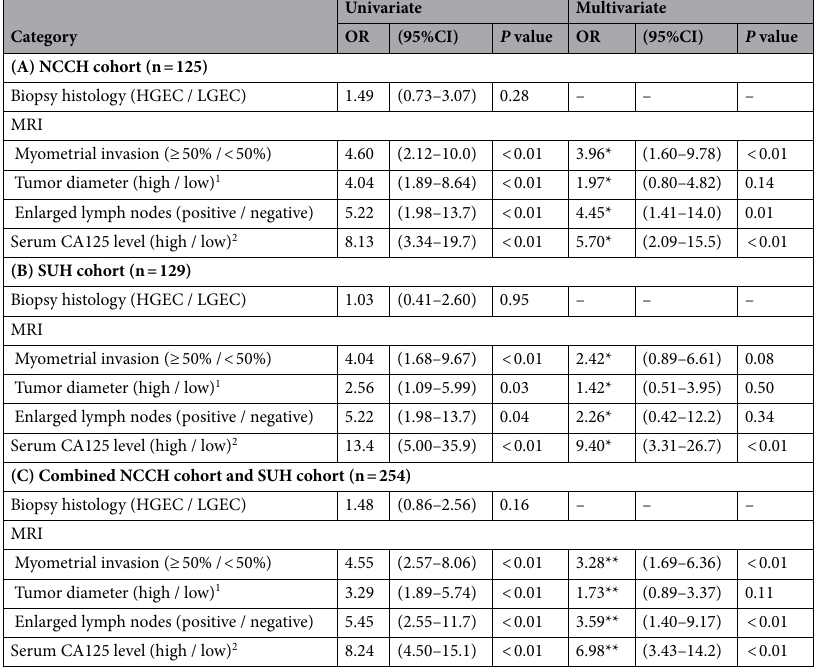
Table 2. Preoperative clinicopathological factors and risk of lymph node metastasis in patients with endometrial cancer. OR Odds ratio, CI Confidence interval, NCCH National Cancer Center Hospital, HGEC High-grade endometrial cancer, LGEC Low-gradeendometrial cancer, MRI Magnetic resonance imaging, CA125 Cancer antigen 125, SUH Showa University Hospital. *Adjusted by statistically significant variables in univariate analysis. **Adjusted by myometrial invasion, enlarged lymph nodes, and serum CA125 level. ***Adjusted by cohort and statistically significant variables in univariate analysis. 1 High level, > 47 mm. 2 High level, > 52.3 U/mL(unmenopause) , > 48